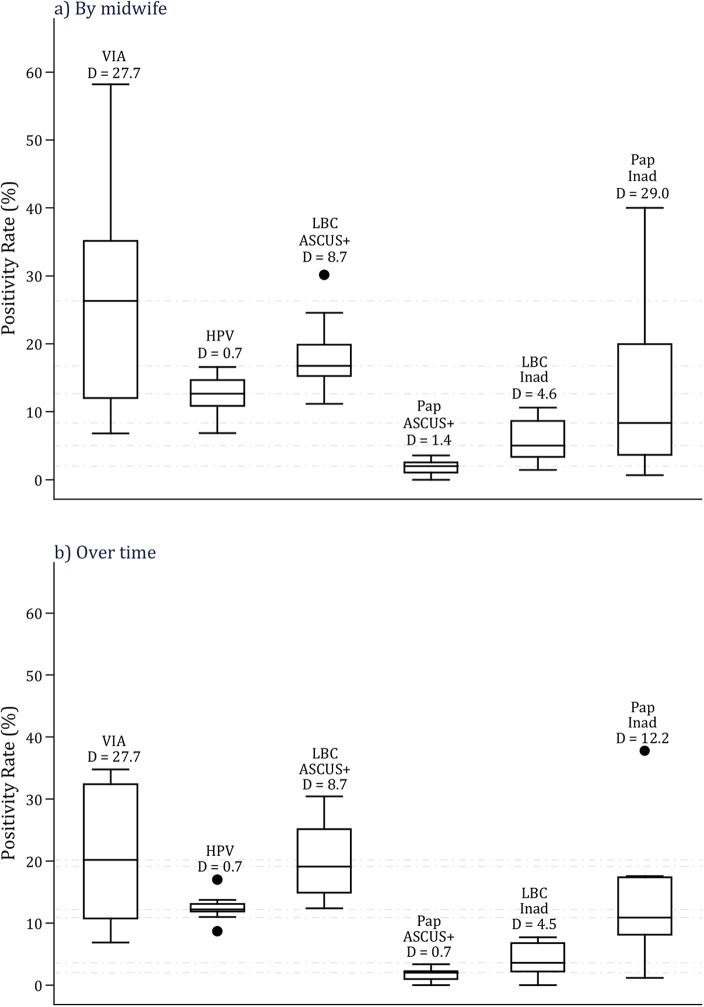
Box plots of positivity rates of VIA, HPV, LBC and Pap and of inadequate rates of LBC and Pap in C-TATI.VIA = Visual inspection after the application of acetic acid. HPV = Human papillomavirus. LBC = Liquid-based cytology. C-TATI = Comparative screening study (months 1–11). D = Dispersion factor. ASCUS+ = Atypical squamous changes of undetermined significance or worse cytological abnormalities. Inad = Inadequate.